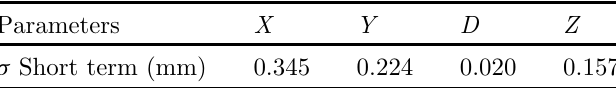
Table 3. Experimental estimation of the intrinsic dispersions of the